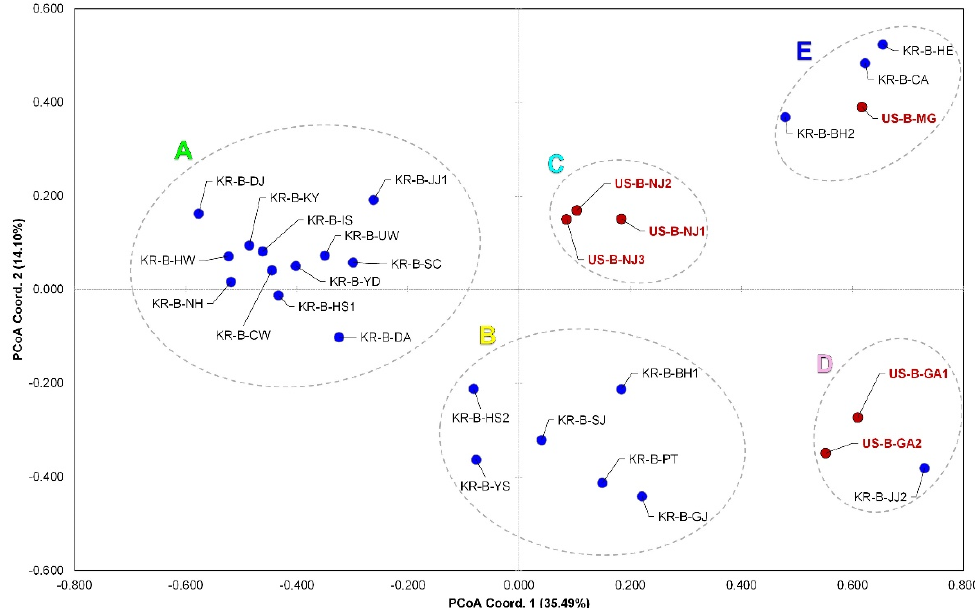
Figure 3. Principal coordinate analysis (PCoA) plotted using microsatellite data from 28 Dasineura oxycoccana blueberry populations from USA and Korea. The X -axis is coordinate 1, ranging from − 0.80 to 0.80, and the Y -axis is coordinate 2, ranging from − 0.60 to 0.60. Red circles correspond to the USA populations, and blue circles correspond to the Korean populations. Letters A–E represent genetically isolated subgroups.